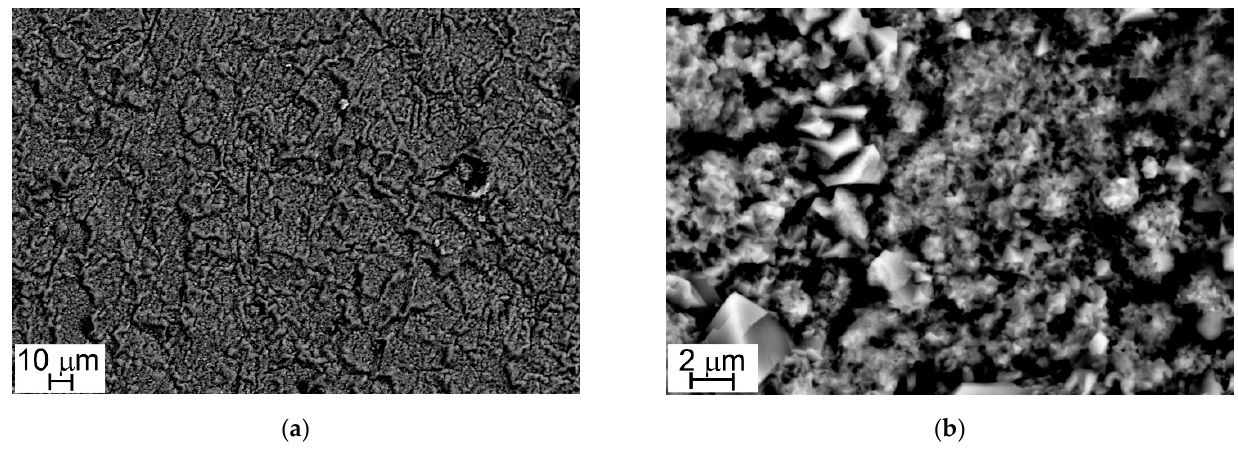
Figure 4. SEM-SE micrographs, Steel A surface (1000×, a ) and (10,000×, b ).